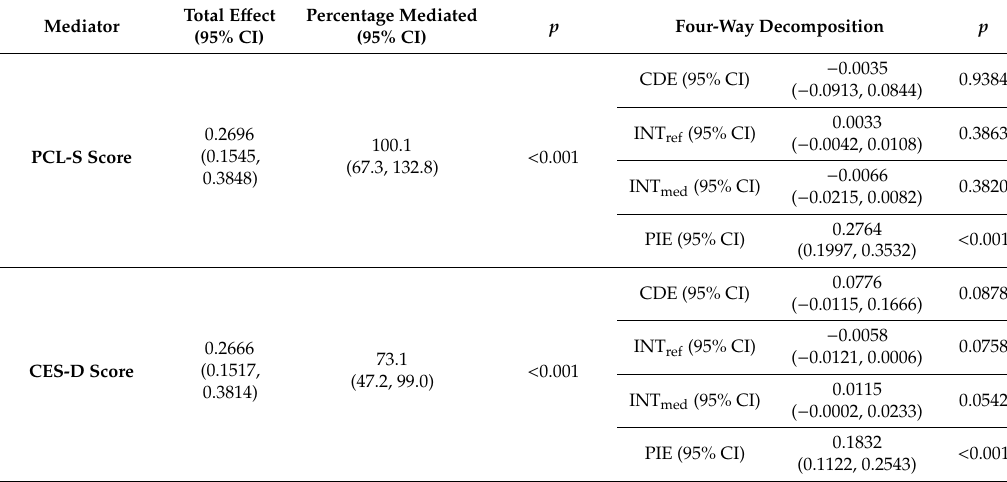
Table 5. Mediators of the association between WTC exposure level and CFI score in FDNY rescue / recovery workers aged >